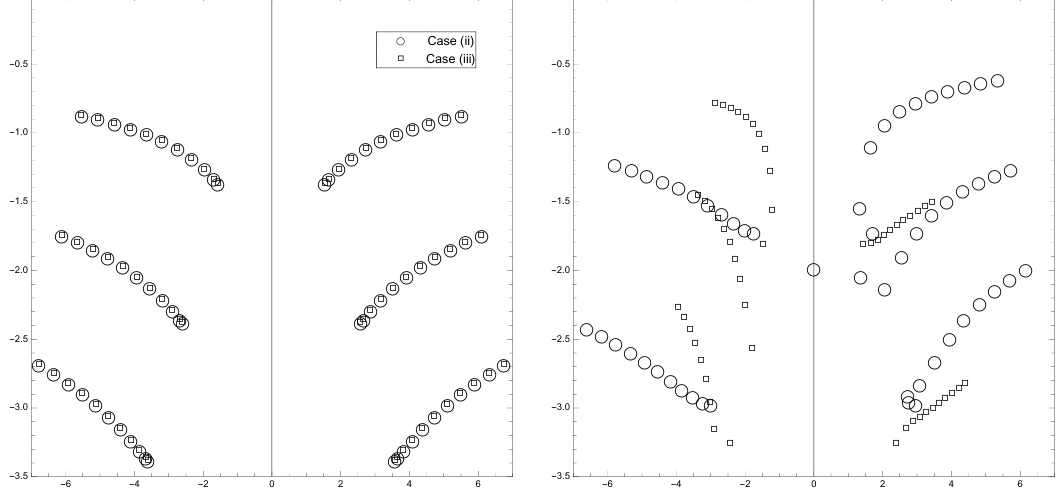
Figure 10 . Comparison of the QNMs of tensor perturbations h xy vs. h ++ . The QNMs of h xy (case (iii)) are shown as squares, those of h ++ (case (ii)) as circles. At a = 0 (left), the QNMs are identical. For a 6 = 0 (right), the QNMs are not